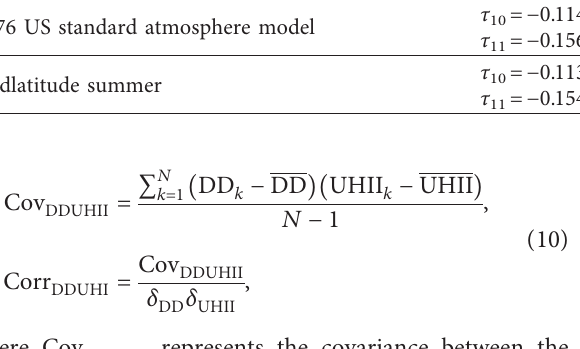
Table 2: Relationships between atmospheric transmittance ( τ ) and water vapor ( ω ) content when the water vapor content is from 0.5 to 3g/cm 2 .